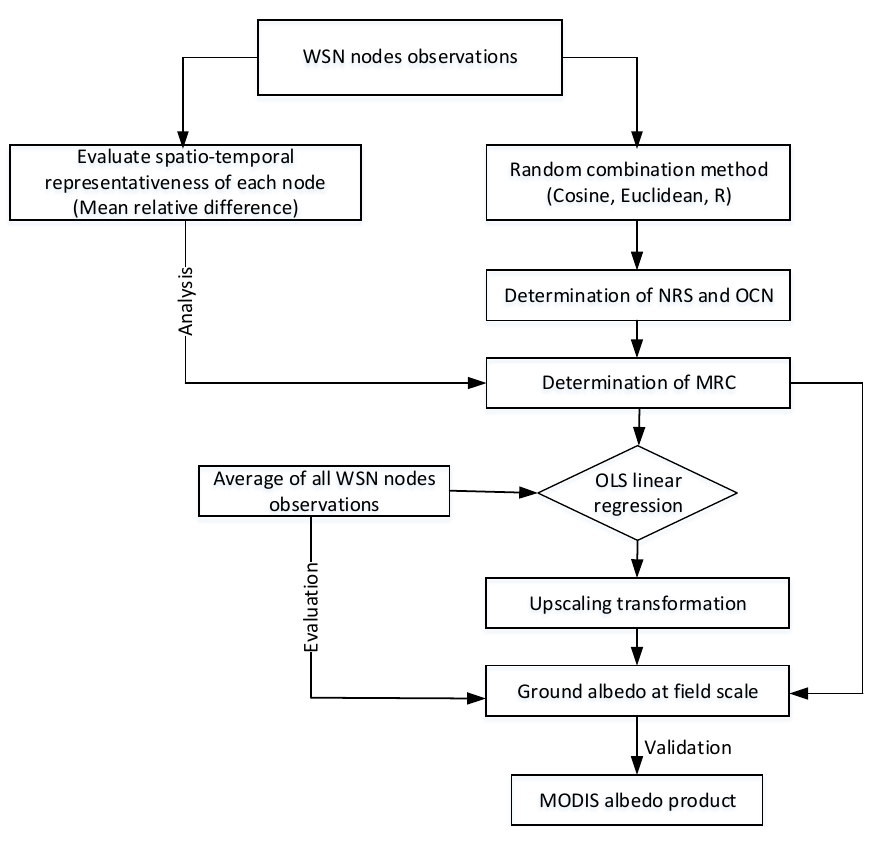
Figure 2. General flowchart of the